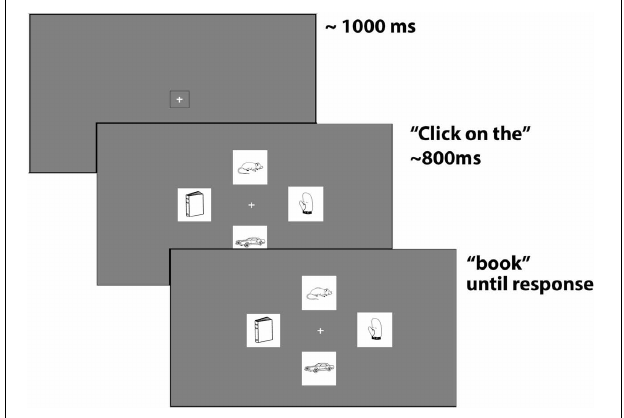
FIGURE 1 | Trial procedure. A trial started with a fixation cross. A box around the fixation cross turned red when a fixation was detected. Four pictures appeared while participants heard “Click on the [target word].” Pictures had been on the screen for about 800ms at the onset of the target word. A trial ended when a mouse response was